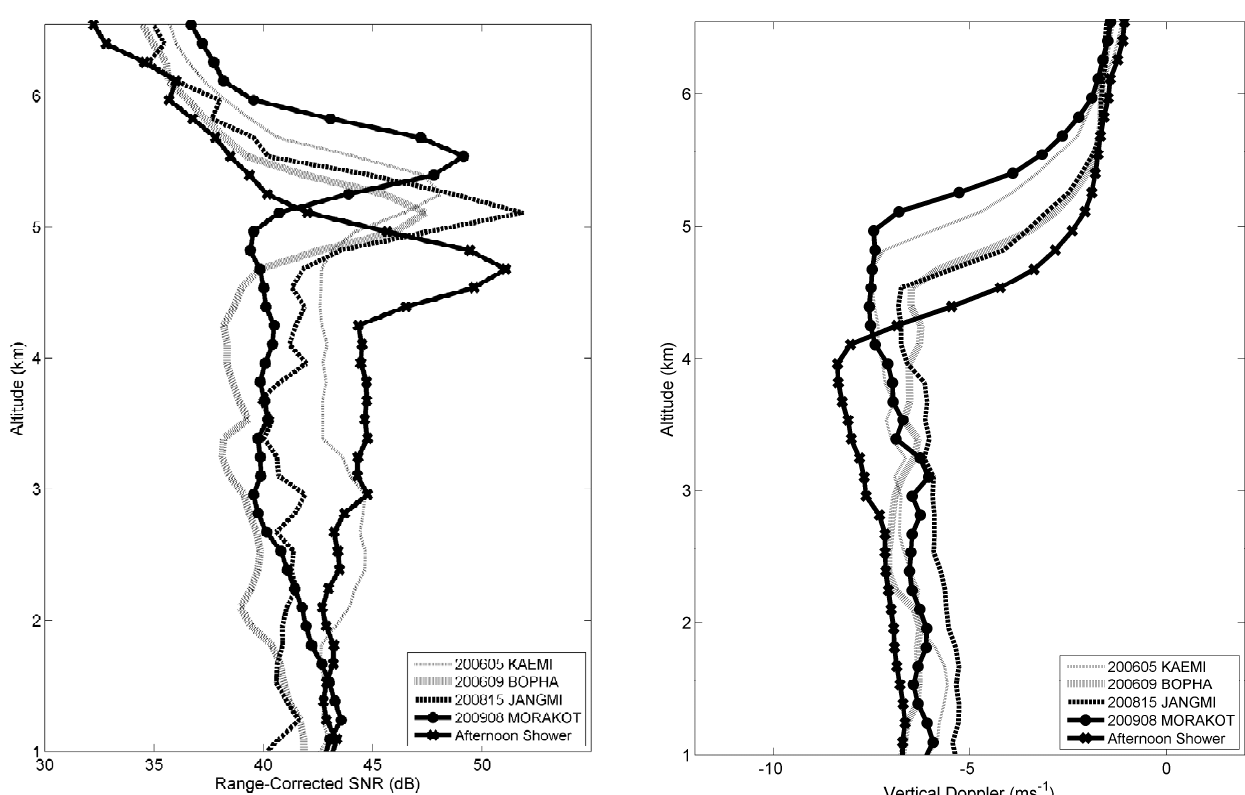
Fig. 2. Vertical Profiles of Signal-to-Noise Ratio [SNR (dB)] Ob- Fig.2: Vertical Profiles of Signal-to-Noise Ratio [SNR (dB)] Observed during passage of four different typhoons and showery precipitation overhead of the wind profiler. served during passage of four different typhoons and showery pre- cipitation overhead of the wind profiler.